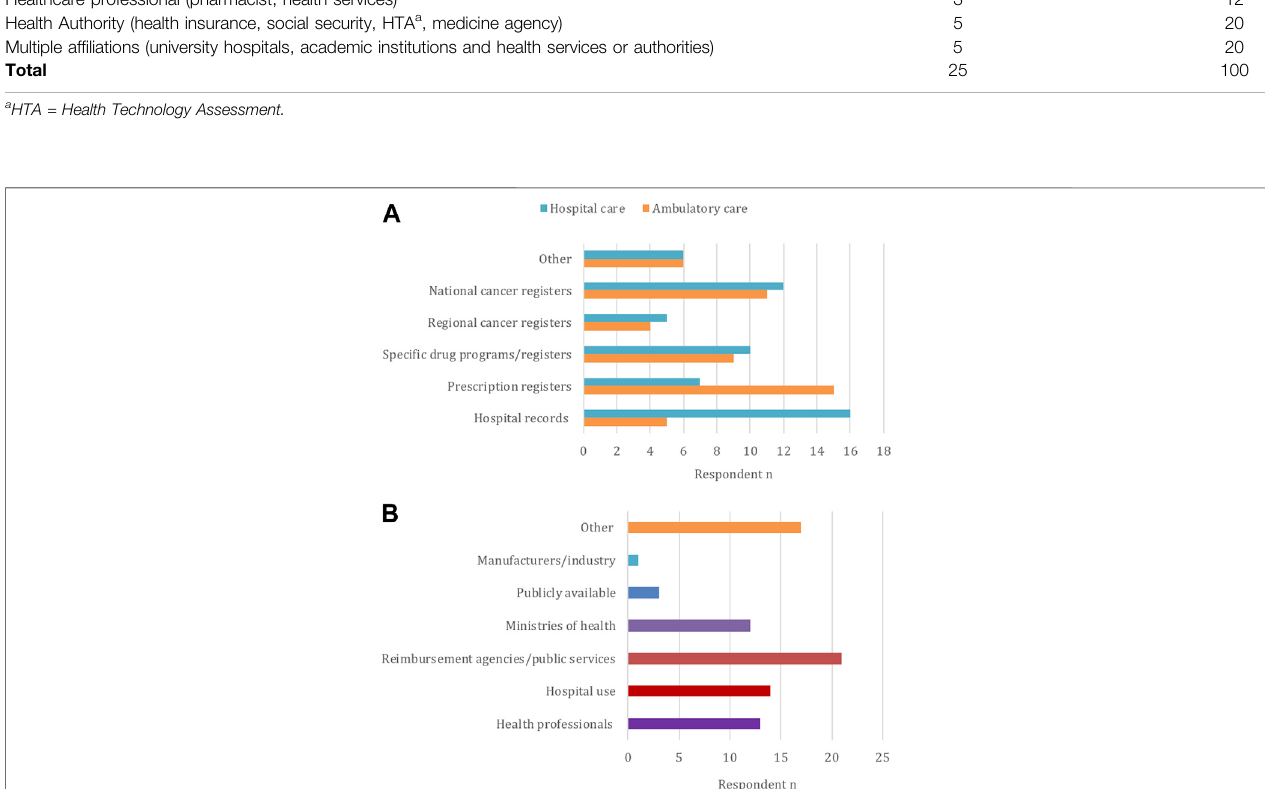
Frontiers in Pharmacology |